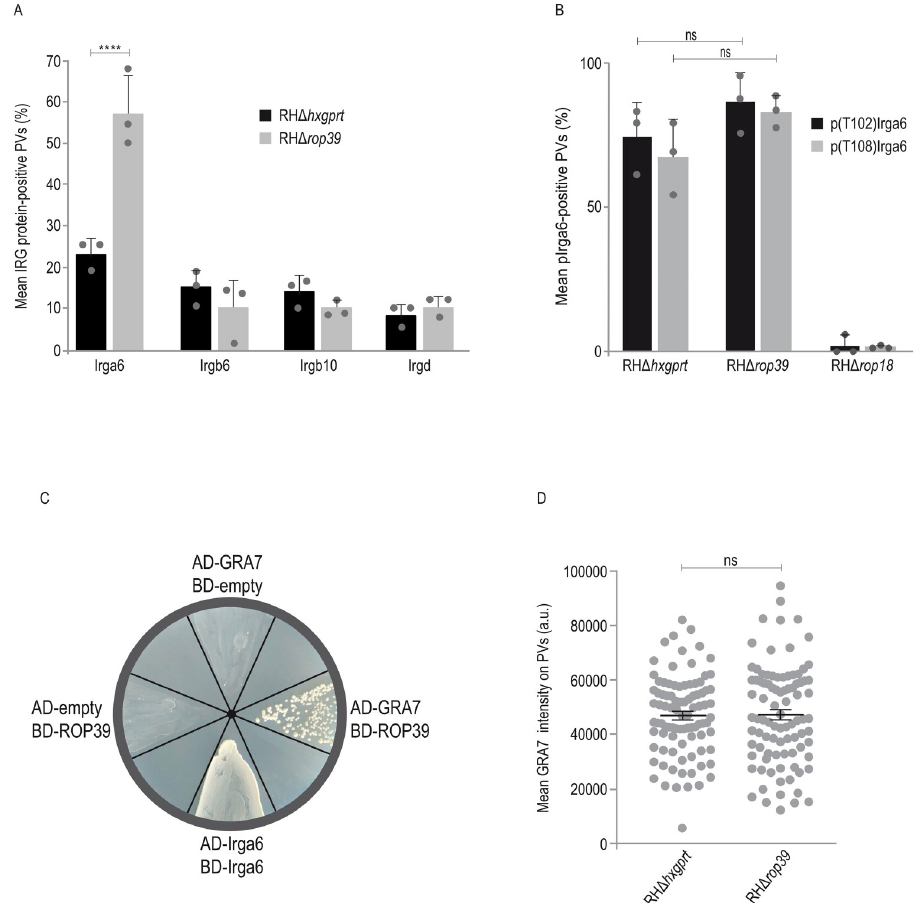
Fig 3. ROP39 inhibits Irga6 loading onto the PVM but is not another Irga6 kinase. A, B, Frequencies of vacuoles positive for Irga6, Irgb6, Irgb10 and Irgd (A) or Irga6 phosphorylated at T108 (p(T108)Irga6) or T102 (p(T102)Irga6) (B). Mouse embryonic fibroblasts were stimulated with IFN γ for 24 h and infected for 2 h before cells were prepared for immunofluorescence. Error bars indicate the mean and standard error of the mean (SEM) of three independent experiments (about 100 vacuoles were evaluated per experiment). Two-way analysis of variance (ANOVA) followed by Sidak´s multiple comparison was used to test differences between groups; ���� p < 0.0001; ns not significant. A, Frequencies of Irga6-positive vacuoles were significantly increased in RH Δ rop39 compared to RH Δ hxgprt infections. B, No differences in percentages of p(T108)Irga6- and p(T102)Irga6-positive vacuoles were detected in RH Δ hxgprt and RH Δ rop39 infections whereas phosphorylation of Irga6 at T108 or T102 is almost completely absent in case of RH Δ rop18 . C, Yeast Two-Hybrid analysis demonstrates direct binding of T . gondii ROP39 to GRA7. D, Intensities of GRA7 at the PVM determined by immunofluorescence with an anti GRA7 antibody. Mouse embryonic fibroblasts were stimulated with IFN γ for 24 h and infected for 2 h before cells were prepared for immunofluorescence. Error bars indicate the mean and standard error of the mean (SEM) of three independent experiments (about 30 vacuoles were evaluated in each experiment). Kruskal–Wallis test followed by Dunn’s multiple comparisons was used to test differences between groups; ns not significant. (See S2, S11 and S14 Figs for data related to A, B,